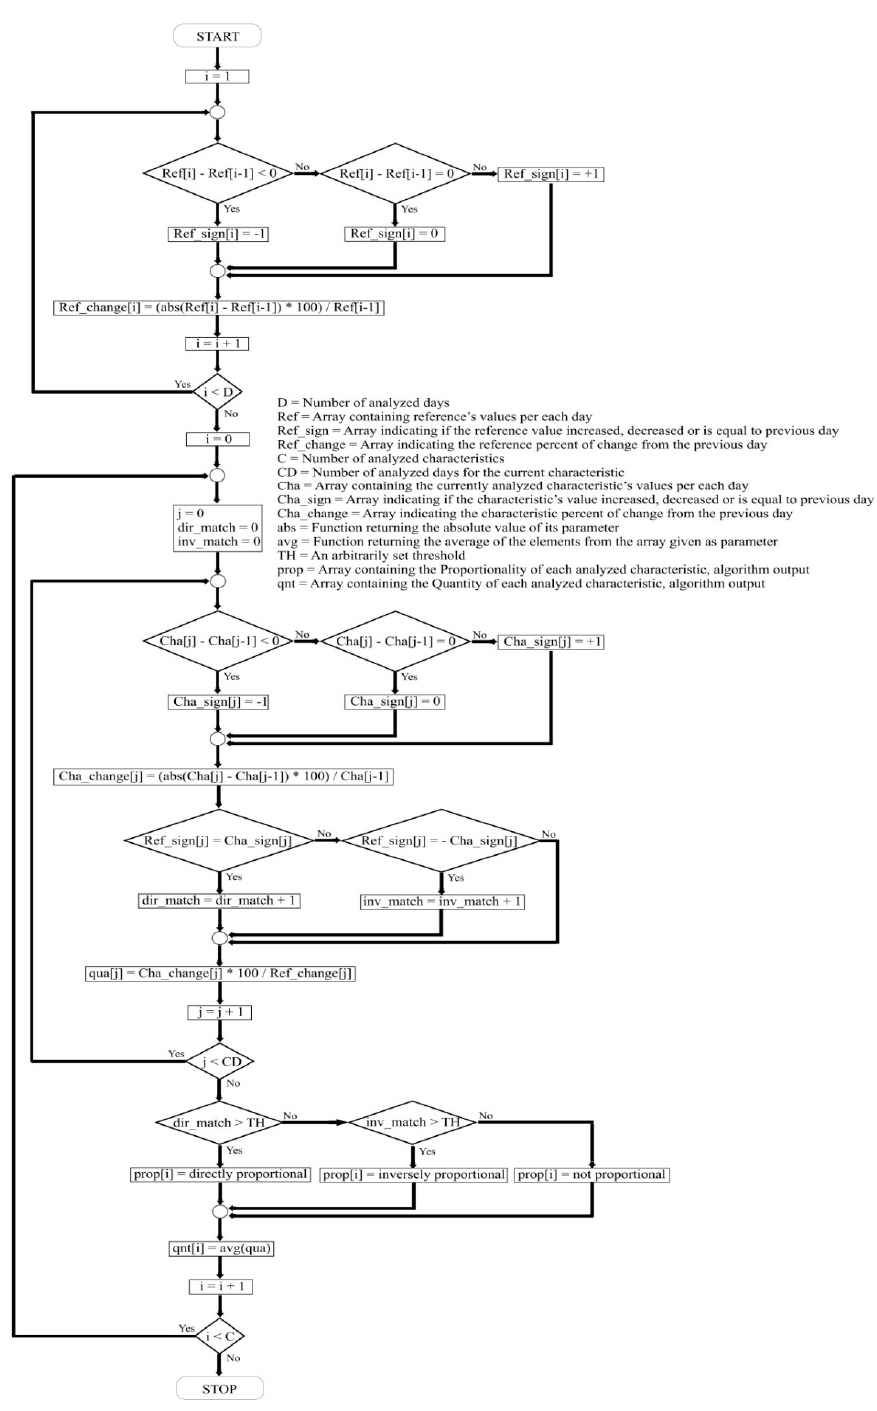
Figure 3. Steps of the data dependency identification algorithm.